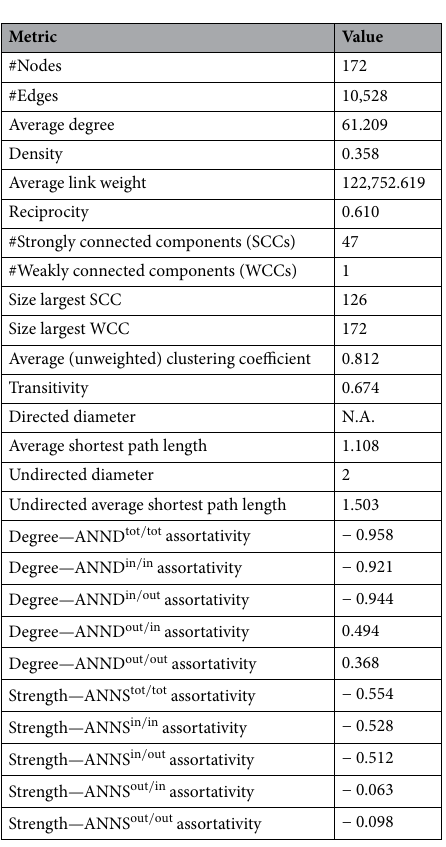
Table 4. Topological analysis of the 2013 food trade